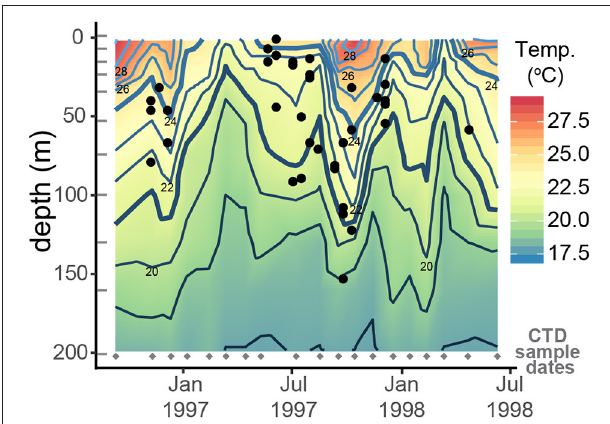
FIGURE 9 | Apparent calcification depths of H. inflatus plotted relative to the seawater temperatures from CTD casts. CTD sampling days are marked by gray diamonds and depths are marked by gray dashes; δ 18 O values in between these points are interpolated. Over eighty percent of H. inflatus apparent calcification depths fall between the 21 and 24 ◦ C contours (bold lines), suggesting that H. inflatus is tracking this habitat throughout the year rather than calcifying at a fixed